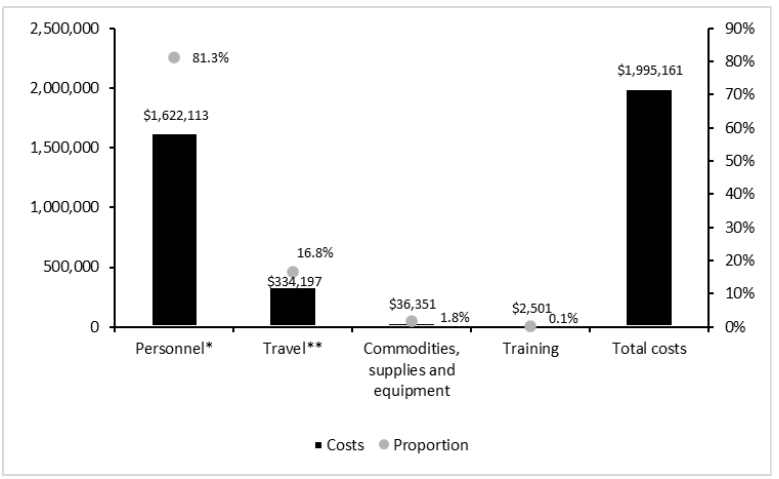
Figure 1. Total program costs by cost category (in 2018 USD). * Wages, salaries, bonuses, and allowances. ** Vehicles, mobile units, drivers, and transport payments made to staff.